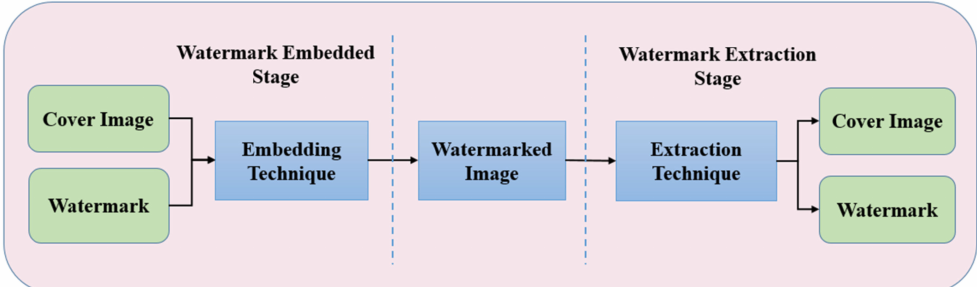
Figure 1. The general process of embedding and extraction operation.